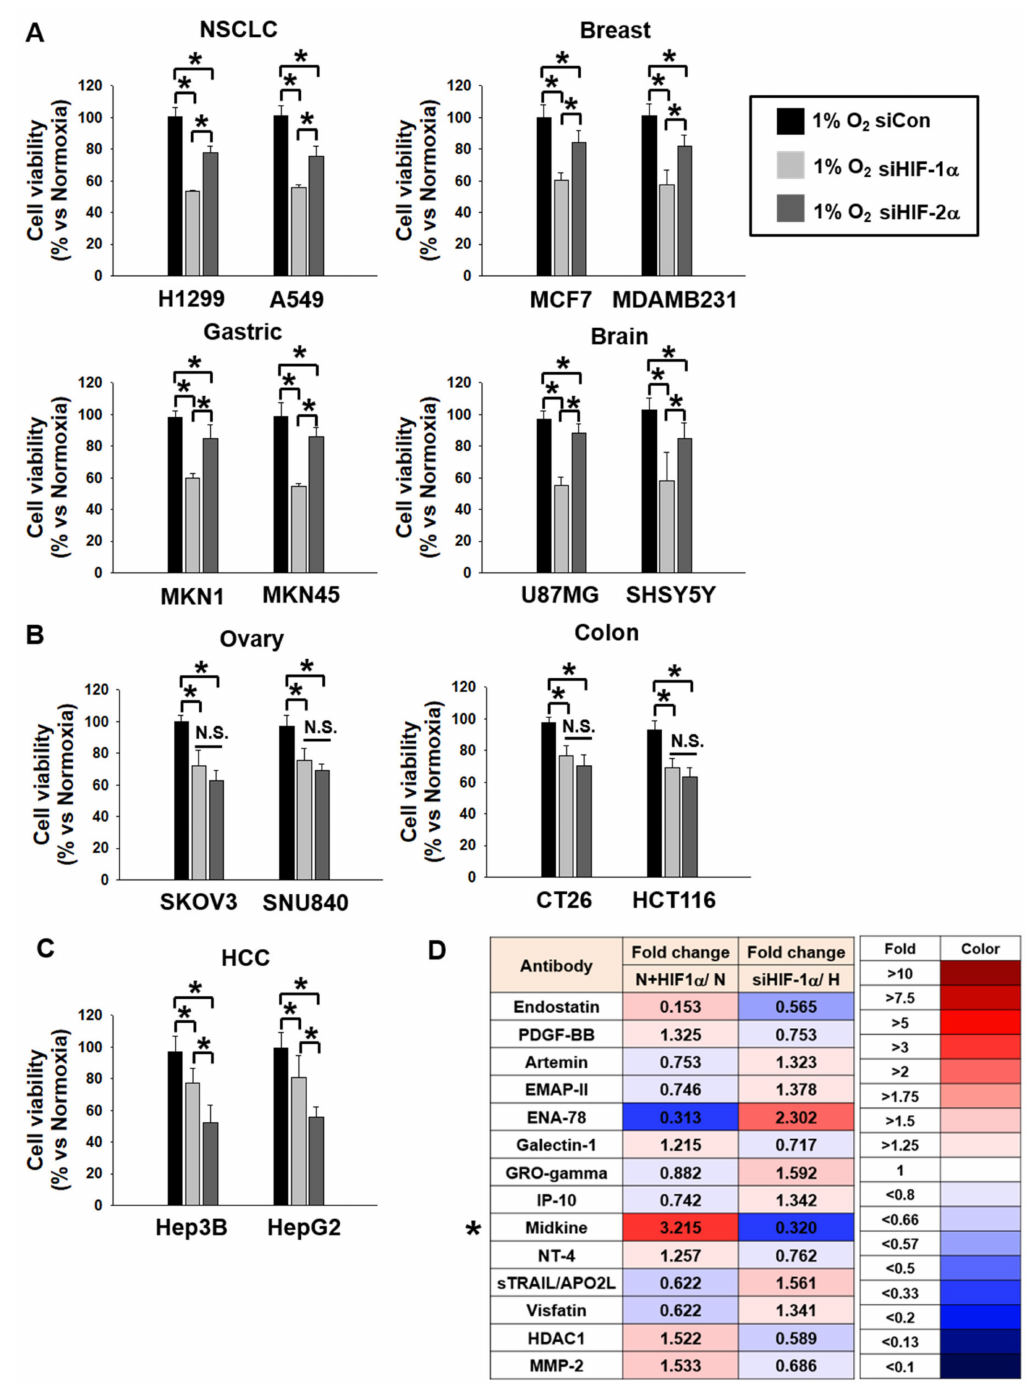
Figure 1. Cell lines were more dependent on HIF-1 α or HIF-2 α . ( A – C ) HIF-1 α and HIF-2 α were knocked down, and then cell viability was measured. H1299, A549 (NSCLC); Hep3B, HepG2 (HCC); HCT116, CT26 (Colon cancer); SKOV3, SNU840 (Ovary cancer); MCF-7, MDAMB231 (Breast cancer); MKN1, MKN45 (Gastric cancer); and U87MG, SHSY5Y (Brain cancer) cells were incubated for 16 h under normoxic (20% O 2 ) or hypoxic (1% O 2 ) conditions after transfection with siCon, siHIF-1 α , and siHIF-2 α . Cell viability was measured using MTS at 56 h after normoxic and hypoxic conditions were imposed. Student’s t -test, average ± SD; n = 6, * p < 0.05. ( D ) List of the top 13 cytokines with increased or decreased levels of secretion following pcDNA, HIF-1 α , siCon, and siHIF-1 α transfection with H1299 cells in normoxic and hypoxic